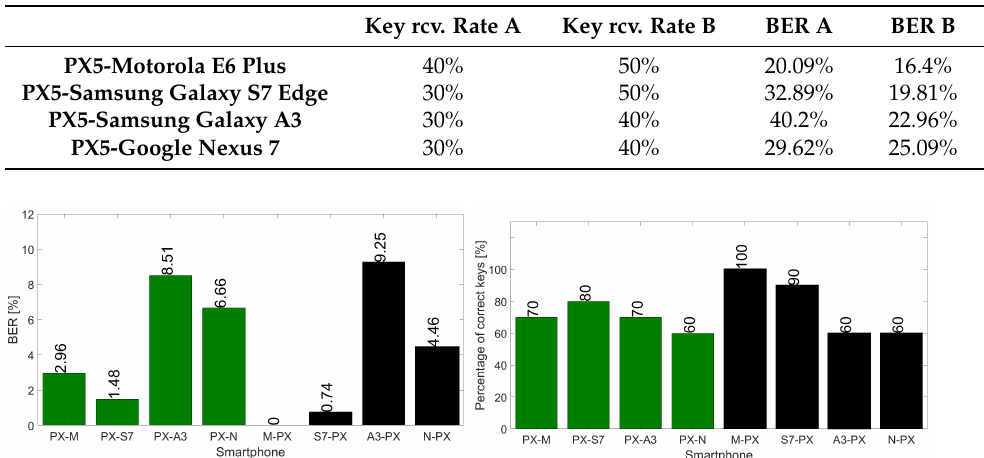
Figure 14. The BER ( left ) and the percentage of correct keys ( right ) for the measurements with the infotainment unit without environmental noise; marked with green when the receiver app is running on PX5 infotainment unit and with black when the receiver app is running on the smartphones.